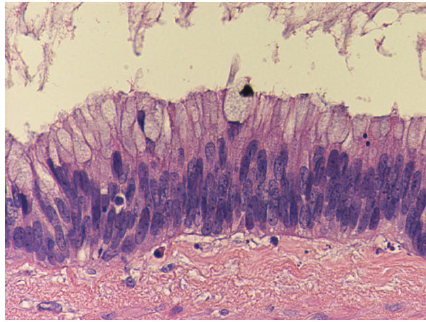
Figure 3: Photomicrograph showing mucinous cystadenoma with mild pleomorphism and nuclear atypia (original magnification × 20, hematoxylin and eosin stain).